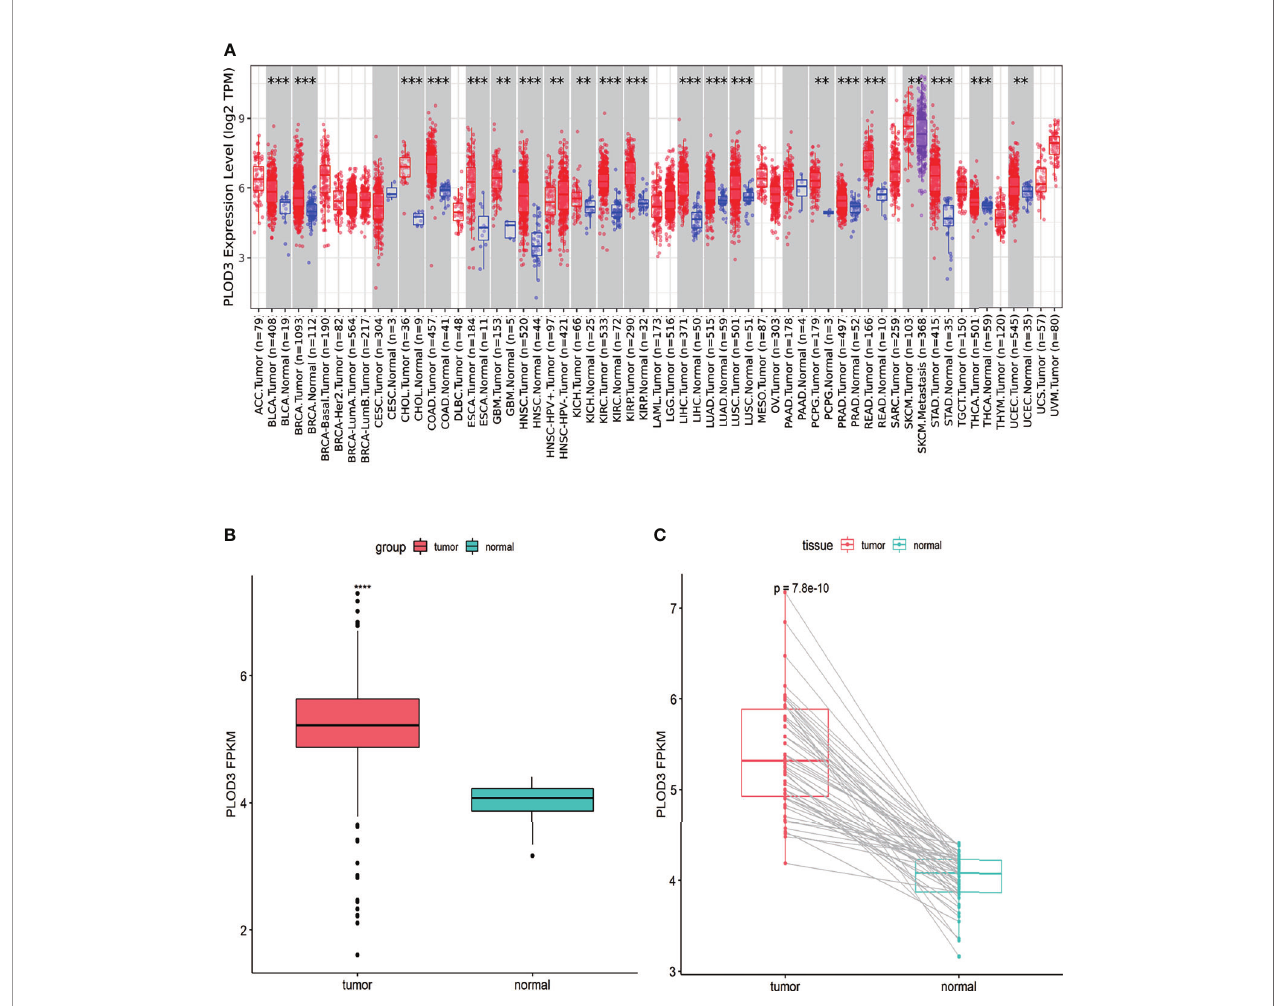
FIGURE 1 | Pan-cancer PLOD3 expression analysis. (A) PLOD3 expression in tumor and normal tissues from pan-cancer data of The Cancer Genome Atlas (TCGA). (B) PLOD3 expression in tumor and normal tissues from CRC obtained from TCGA. (C) PLOD3 expression in paired CRC tumor and normal tissues from TCGA. Data are expressed as the mean ± SD. ** p < 0.01, *** p < 0.001, **** p <